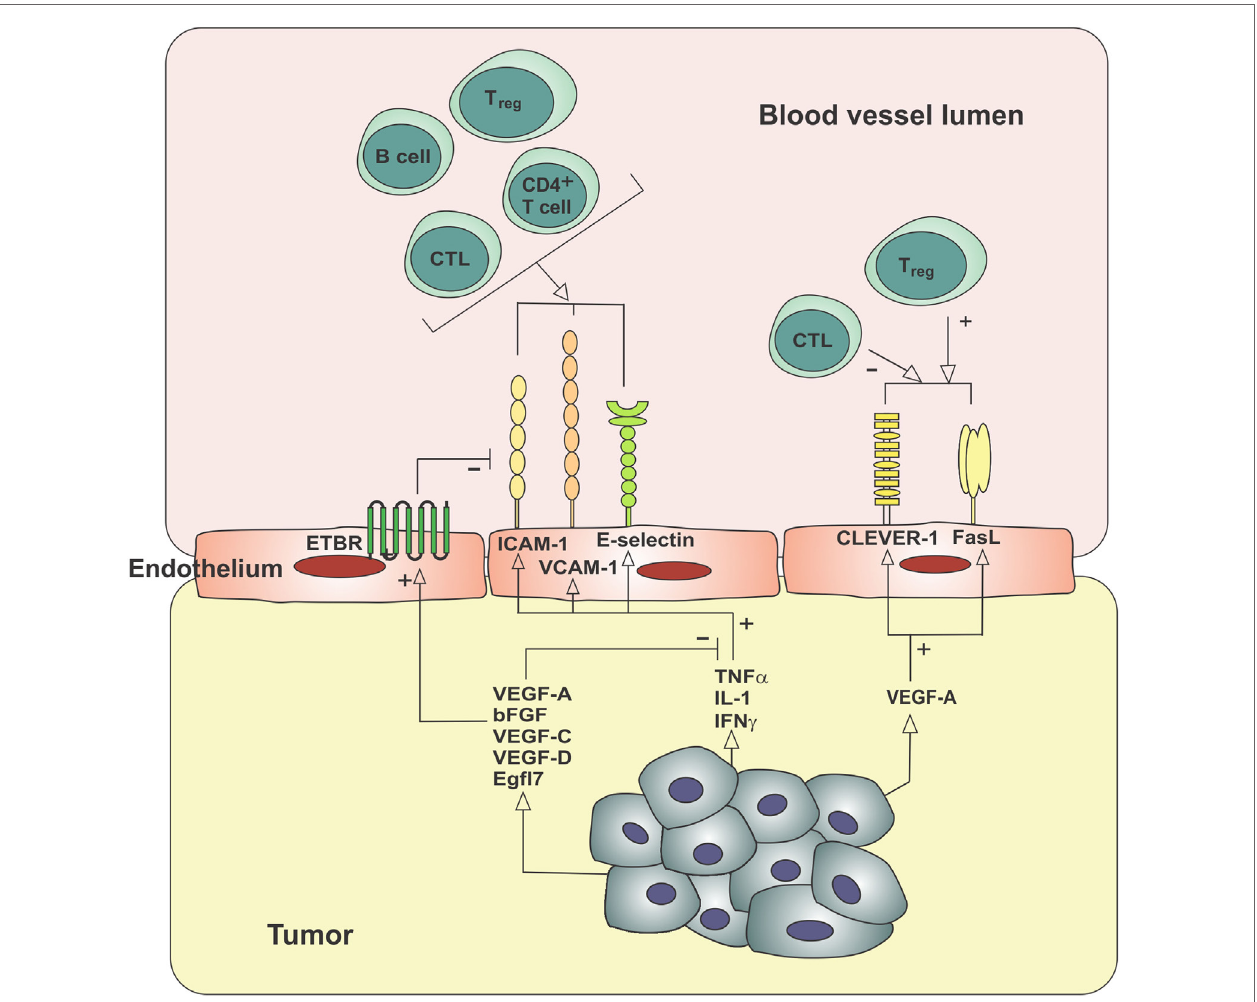
FigURe 2 | Molecular mechanisms contributing to the exclusion of immune cells from the tumor microenvironment . Tumor-derived angiogenic factors can block the usual upregulation of cell adhesion molecules in response to inflammatory mediators (endothelial anergy), increase the expression of ETBR, which blocks the clustering of ICAM-1 required for lymphocyte adhesion, and increase expression of cell surface receptors, which selectively decrease CTL extravasation while increasing T reg extravasation. bFGF, basic fibroblast growth factor; CLEVER-1, common lymphatic endothelial and vascular endothelial receptor-1; CTL, cytotoxic T lymphocyte; EGFL7, epidermal growth factor-like domain 7; ETBR, endothelin B receptor; FasL, Fas ligand; ICAM-1, intercellular adhesion molecule-1; IFN γ , interferon-gamma; IL-1, interleukin-1; TNF α , tumor necrosis factor- α ; T reg , regulatory T cell; VCAM-1, vascular cell adhesion molecule-1; VEGF, vascular endothelial growth